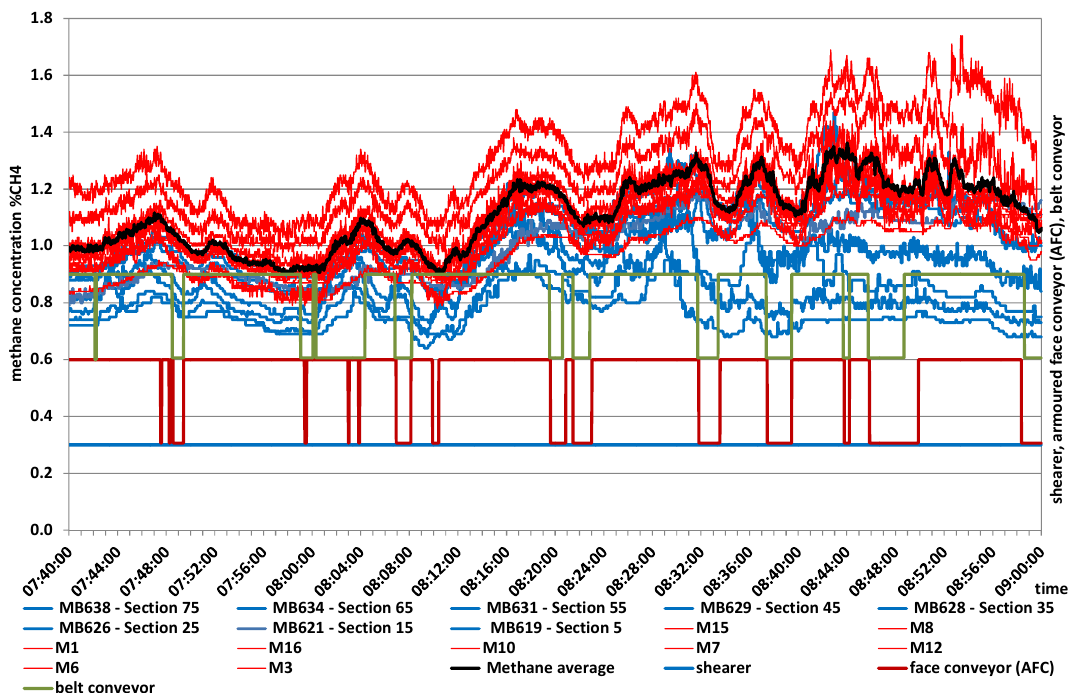
Figure 9. Comparison of the recorded methane concentrations using the wireless sensors and the multi-point system in longwall Cw-4 between 7:40 and 9:00, in relation to equipment operation.